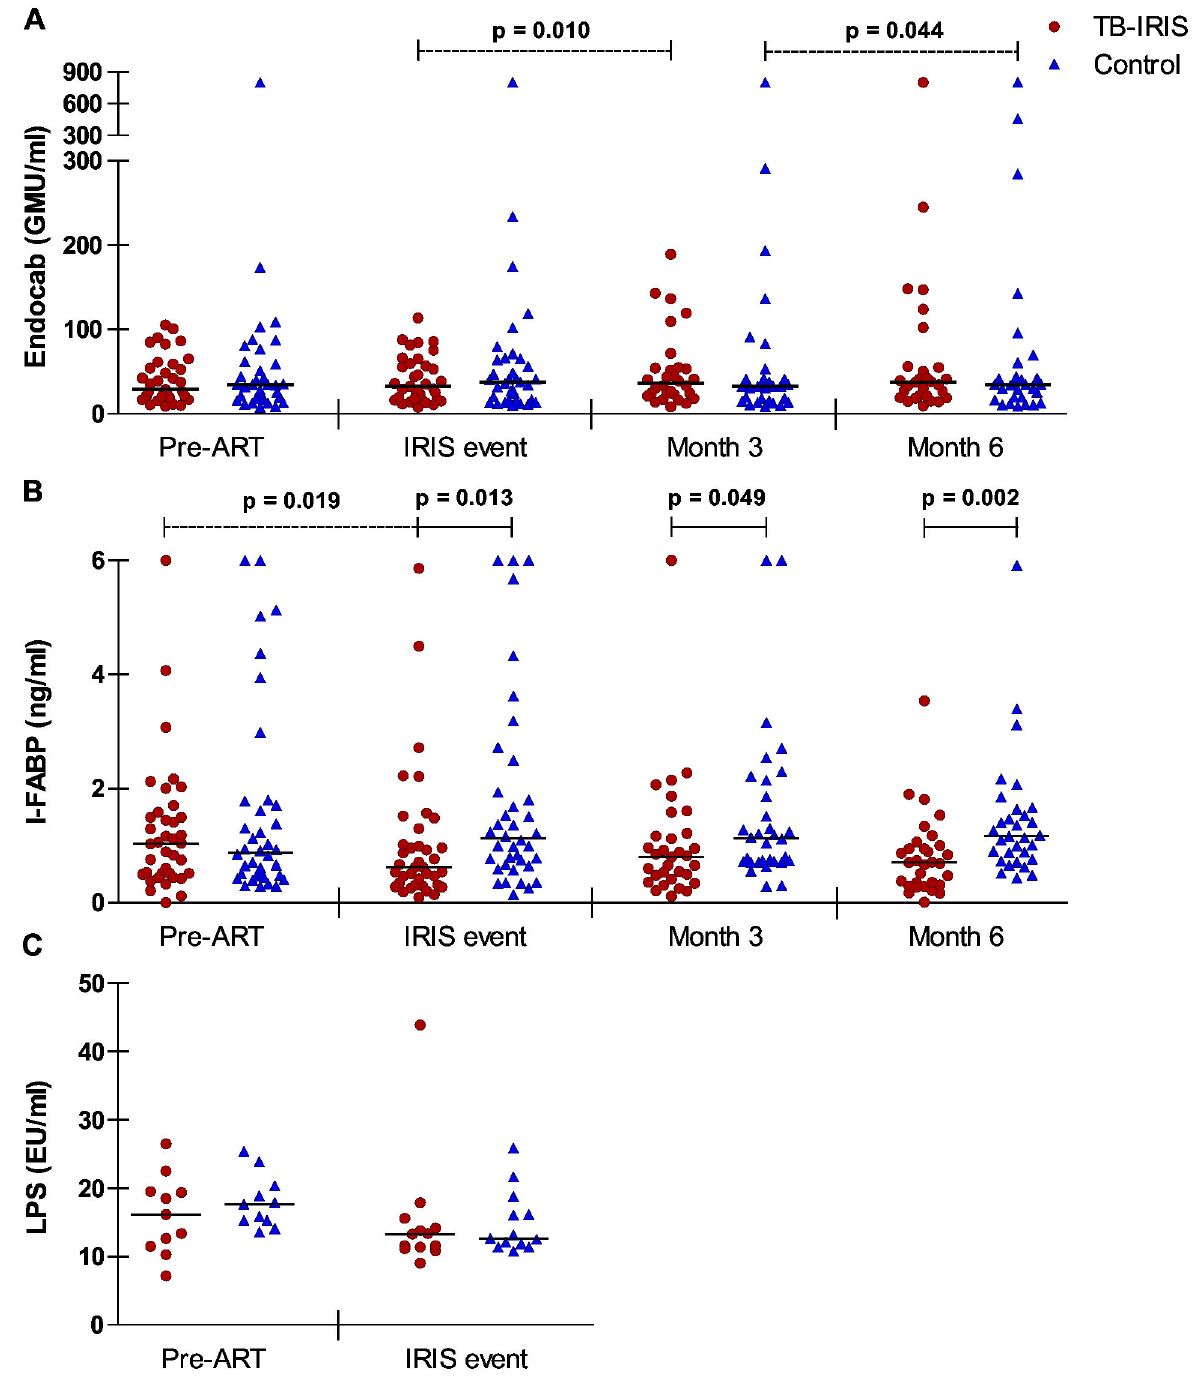
Figure 1. Markers of a leaky gut in TB-IRIS patients and controls during follow-up. Horizontal lines represent median plasma levels for each patient group at each time point. A Wilcoxon signed-rank test was used to calculate p values. The level of significance was set to p < 0.05. Dotted lines indicate significant changes over time per patient-group and full lines indicate significant differences between matched patients. (A) EndoCab. Number of patients in each group during consecutive time points is 35, 35, 30 and 29 respectively. (B) I-FABP. Number of patients in each group during consecutive time points is 38, 38, 32 and 31 respectively. (C) LPS. Number of patients in each group during consecutive time points is 11 and 13 respectively. GMU, IgG median units; EU, endotoxin units.